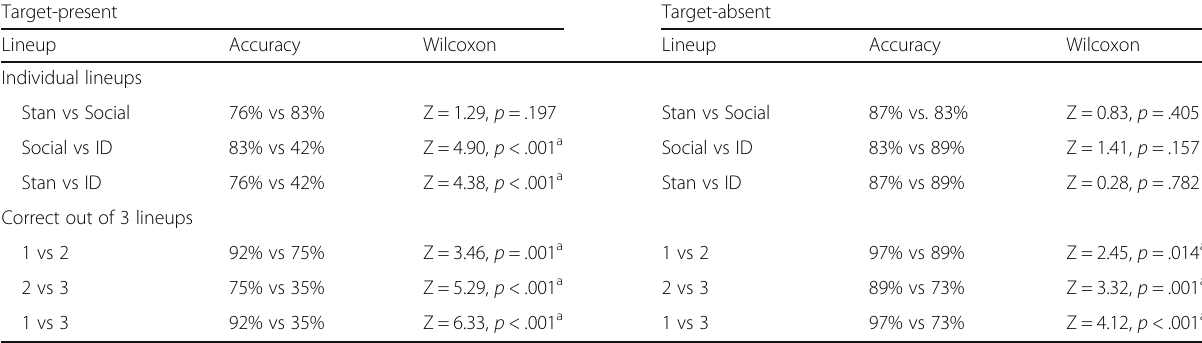
Table 3 A summary of statistical comparisons (Wilcoxon signed-rank test) for individual lineup accuracy and for accuracy out